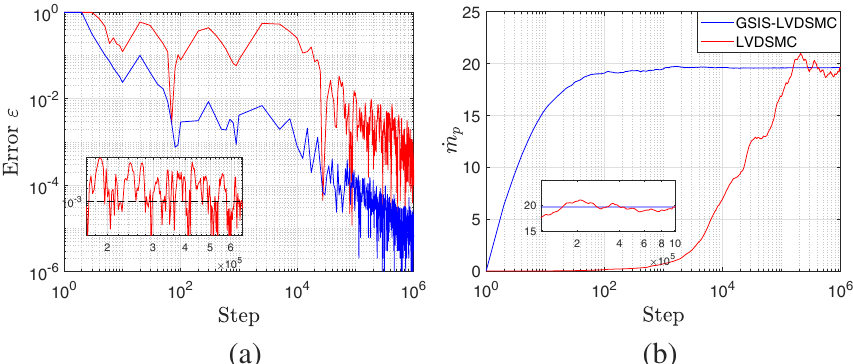
Fig. 6 History of convergence in the 1D Poiseuille flow solved by GSIS-LVDSMC (blue lines) and LVDSMC (red lines) when Kn = 0.01 . a relative error ε (42) and b mass flow